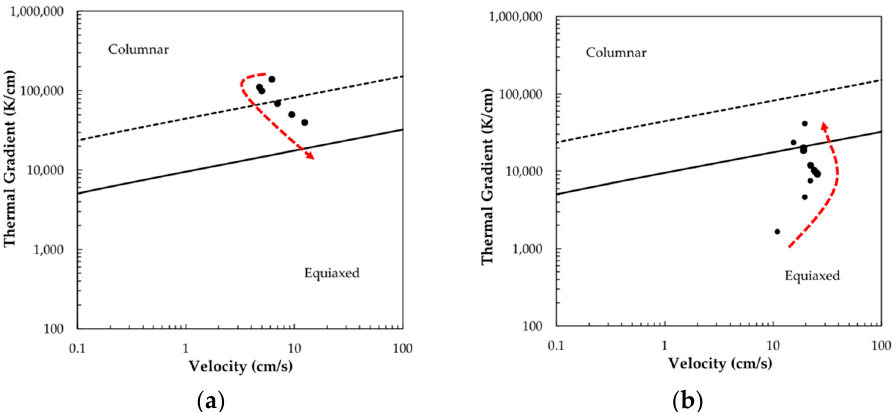
Figure 9. Predicted SYSWELD G-V conditions from the edge to the center of a melt pool or beginning to end of a raster overlaid onto the Ti-1023 CET for ( a ) 139 W spot-melt and ( b ) 53.5 W and 0.25 m/s raster. Note: arrows in ( a , b ) show progression of solidification.